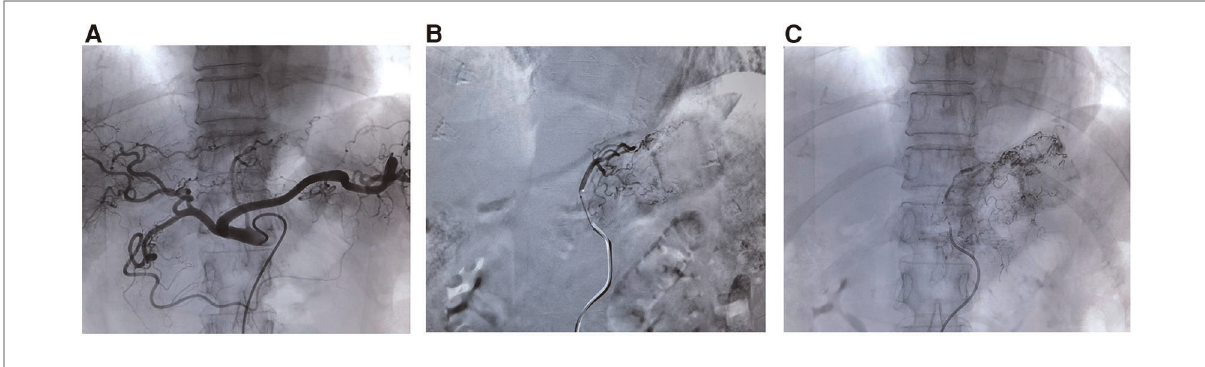
FIGURE 1 The procedures of GTC. ( A ) Contrast medium injected into celiac trunk to show blood supply; ( B ) superselected into the left gastric artery; ( C ) oxaliplatin, docetaxel and lipiodol mixed with oxaliplatin injected sequentially. GTC, gastric transcatheter